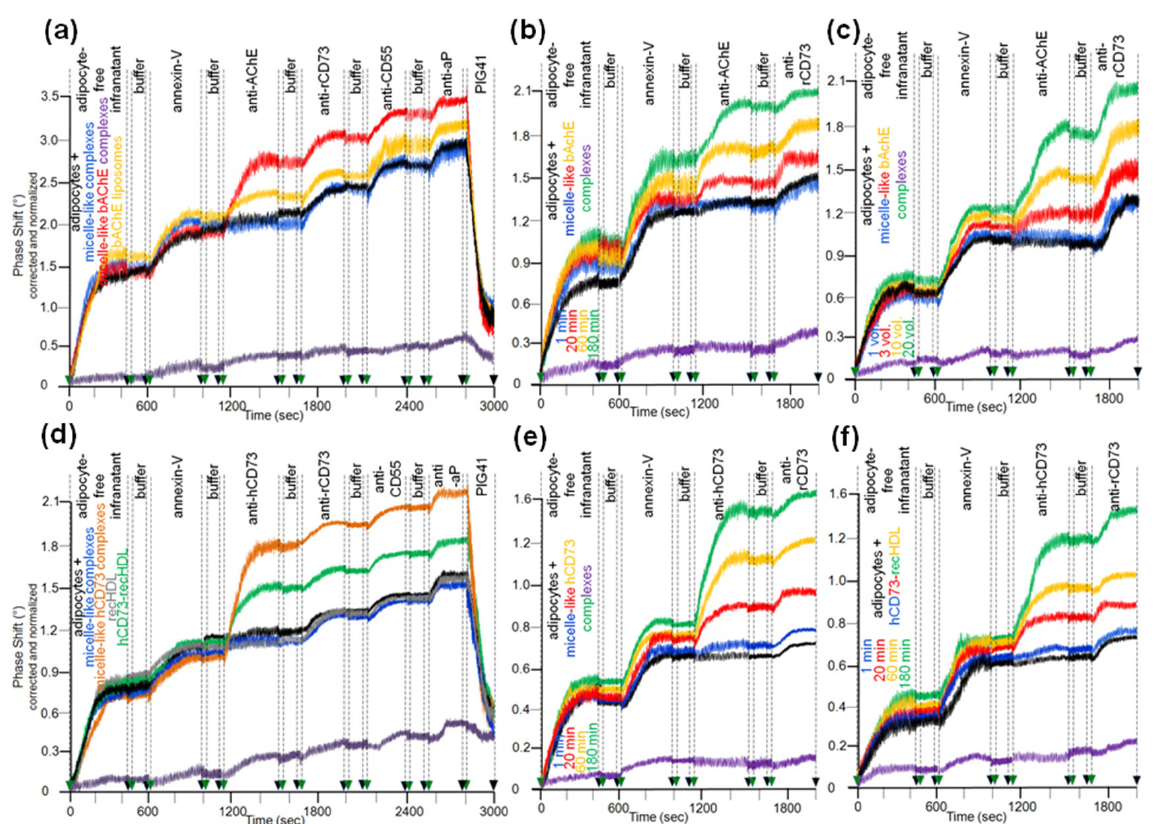
Figure 7. Translocation of bAChE and hCD73 from micelle-like complexes, liposomes, and HDLs to rat adipocytes. Isolated rat adipocytes were initially incubated ( a , c , d , 180 min; b , e , f , 1–180 min) in the absence (black curves) or presence of liposomes (only a , orange curve), HDL ( d , f , 10 volume equivalents) or micelle-like complexes ( a , b , d , e , 20 volume equivalents; c , 1–20 volume equivalents) reconstituted without ( a , d , blue and grey curves) or with bAChE ( a , red, purple, and orange curves; b , c ) or hCD73 ( d , brown and green curves; e , f ). The incubation mixtures were centrifuged through a cushion of dinonylphtalate. The adipocytes above the dinonylphtalate cushion were removed, washed two by flotation and then assayed for the amount of translocated bAChE ( a–c ) or hCD73 ( d – f ) by determination of their spontaneous release into micelle-like complexes upon subsequent incubation (37 ◦ C) for 90 min ( a – f ) or 1 min (purple curves; a – c , only for micelle-like bAChE complexes; d , e , only for micelle-like hCD73 complexes; f , only for hCD73-recHDL). After centrifugation of the incubation mixtures through a cushion of dinonylphtalate, the adipocyte-free infranatants below the cushions were injected into α -toxin-coated chips. Following washing of the chips, the presence of GPI-APs, including the translocated bAChE and hCD73, was assayed by sequential injection of annexin-V (in the presence of Ca 2+ ), anti-AChE ( a – c ), anti-rCD73 ( a – f ), and anti-hCD73 ( d – f ), as well as anti-CD55 and anti-aP ( a , d ) antibodies as indicated, with washings between each injection cycle. PIG41 was injected after the final antibody injection ( a , d ). Correction and normalization of the phase shift were performed as described for Figure